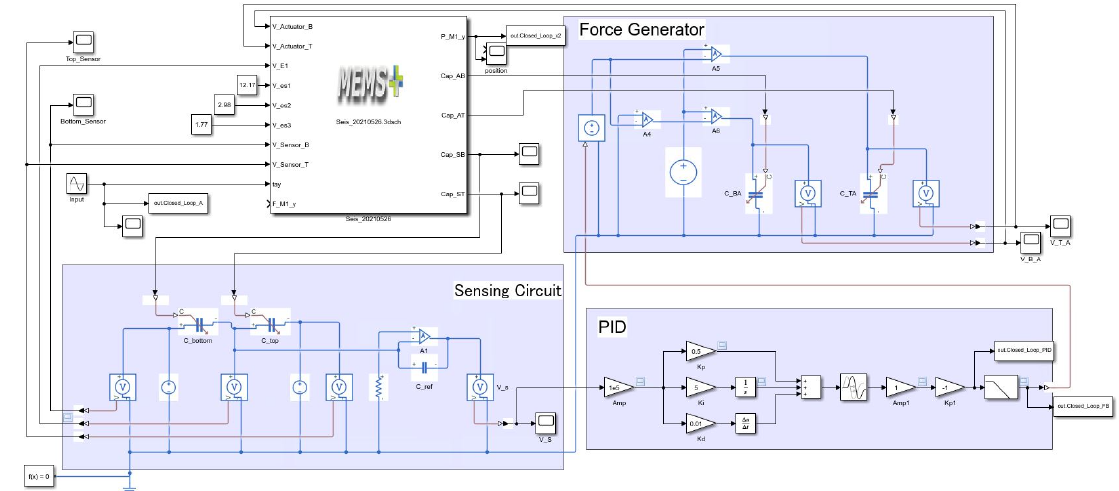
Figure 10. Block diagram of the multi-domain simulation.